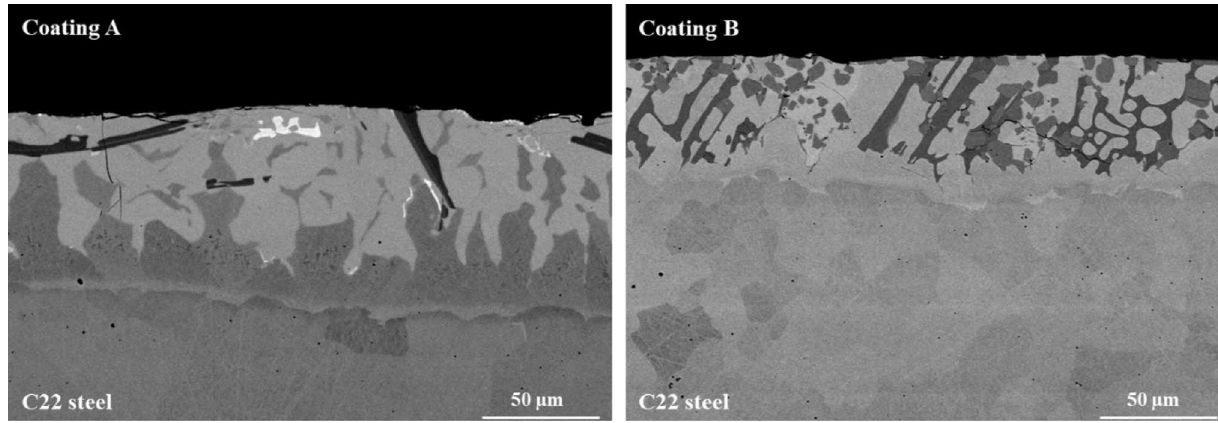
Fig. 1 SEM observations of a cross section of the coatings A and B with the substrate (C22 steel)